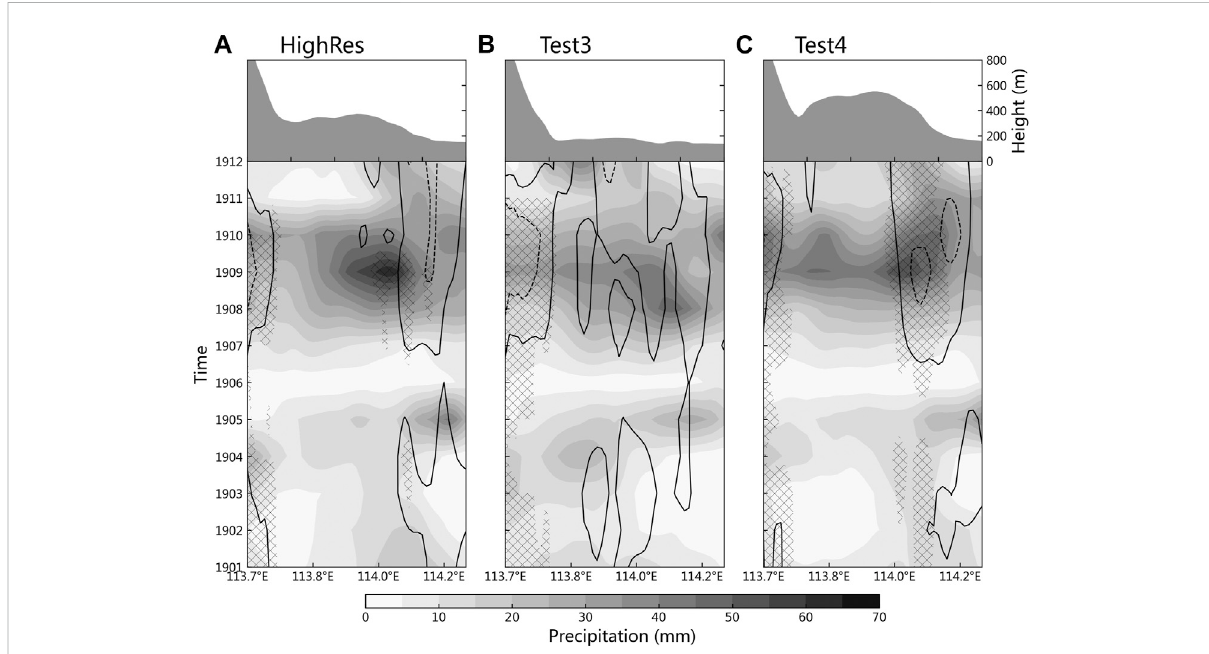
FIGURE 10 Meridionally averaged hourly precipitation, the average vertical velocity below the altitude of 1,000 m (contour; the interval is 0.1 m s − 1 for the solid line and 0.3 m s − 1 for the dashed line), the vertical velocity due to topographically forced uplift (shaded area fi lled by diagonal lines, unit: 0.1 m s − 1 ), and the meridionally averaged altitude in the area D6 from 0100 UTC to 1200 UTC on 19 July 2016 in the (A) HighRes , (B) Test3 , and (C) Test4